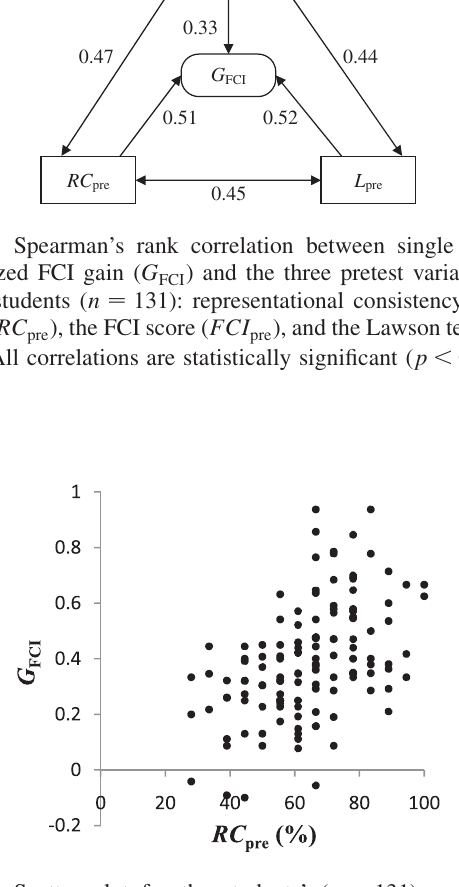
FIG. 4. Scatter plot for the students’ ( n ¼ 131 ) representa- tional consistency on the R-FCI pretest ( RC pre ) and the single student normalized FCI gain ( G FCI ). Spearman’s rank correlation is 0.51 ( p < 0 : 001 ).